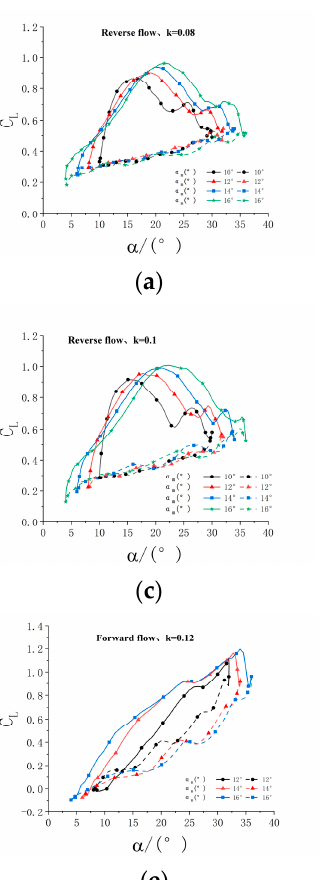
Table 9. Experimental conditions of varying pitch amplitude at different reduced